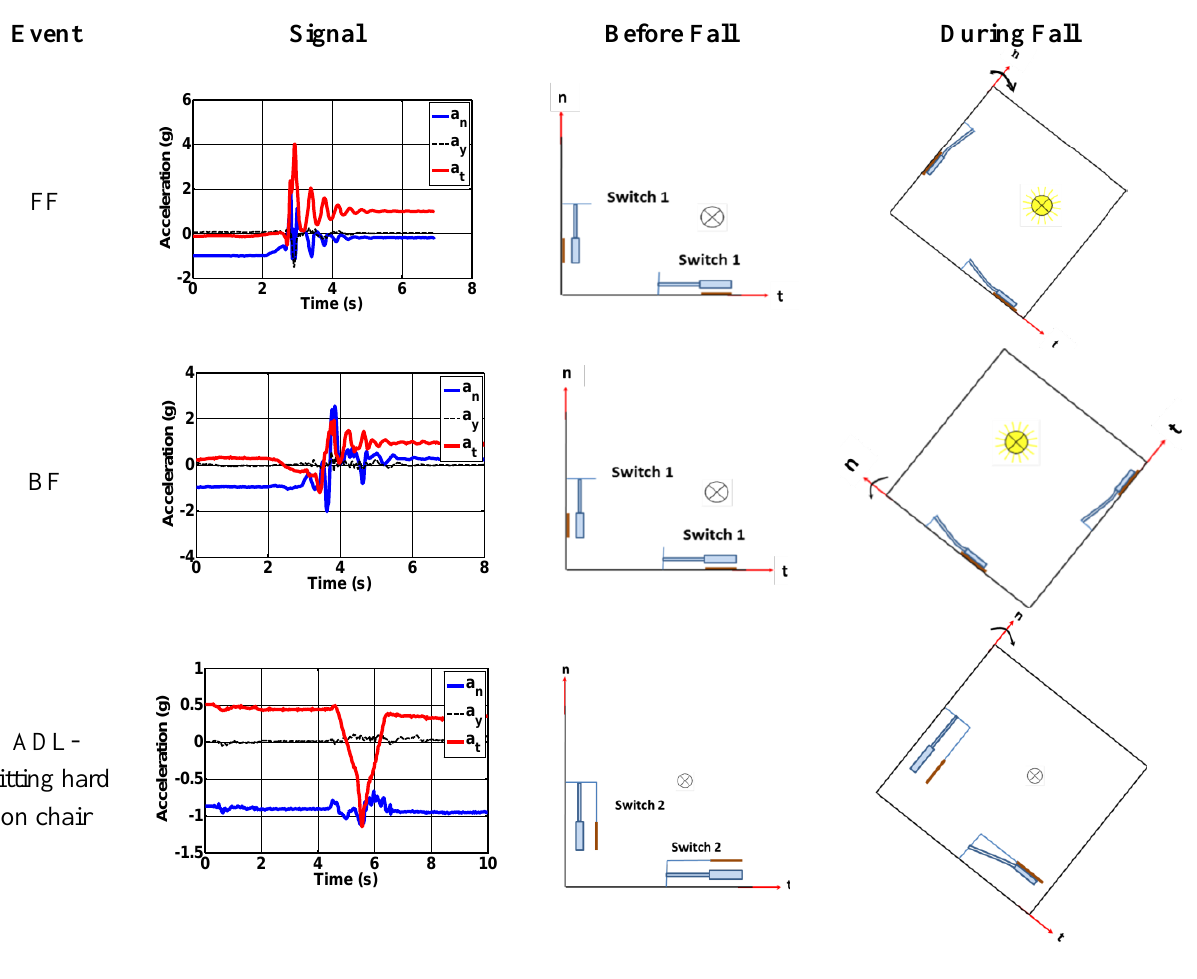
Figure 11. The switch response under falls and ADL signals for the chest